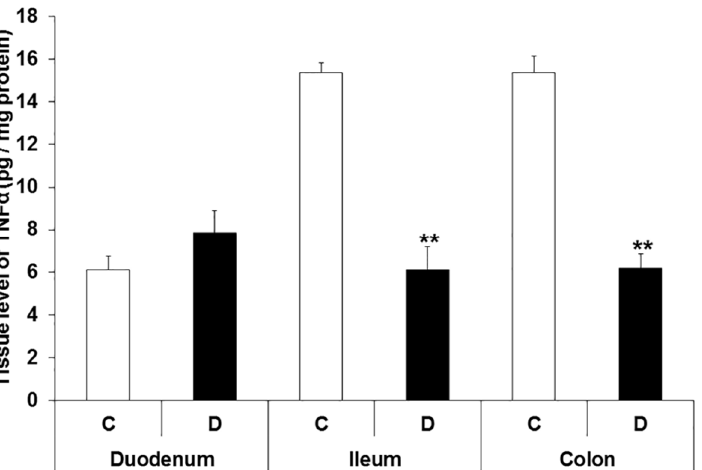
Figure 7. The tissue level of TNF α in the homogenates of mucosa and submucosa, including submucous plexus, from the different gut segments of control and diabetic rats. The level of TNF α was the lowest in the tissue homogenates from the duodenum of controls, while it was more than twice as high in the distal part of the gastrointestinal tract. A statistically significant decrease was observed in TNF α levels in the tissue homogenates of ileum and colon, but not of the duodenum of diabetic rats. Data were expressed as means ± SEM. ** p < 0.01 (between controls and diabetics). C—controls; D—diabetics.